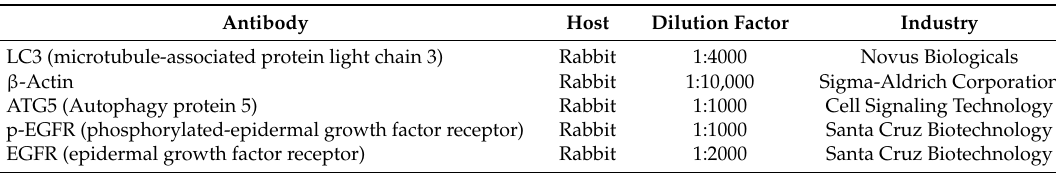
Table 1. Primary antibodies used in the